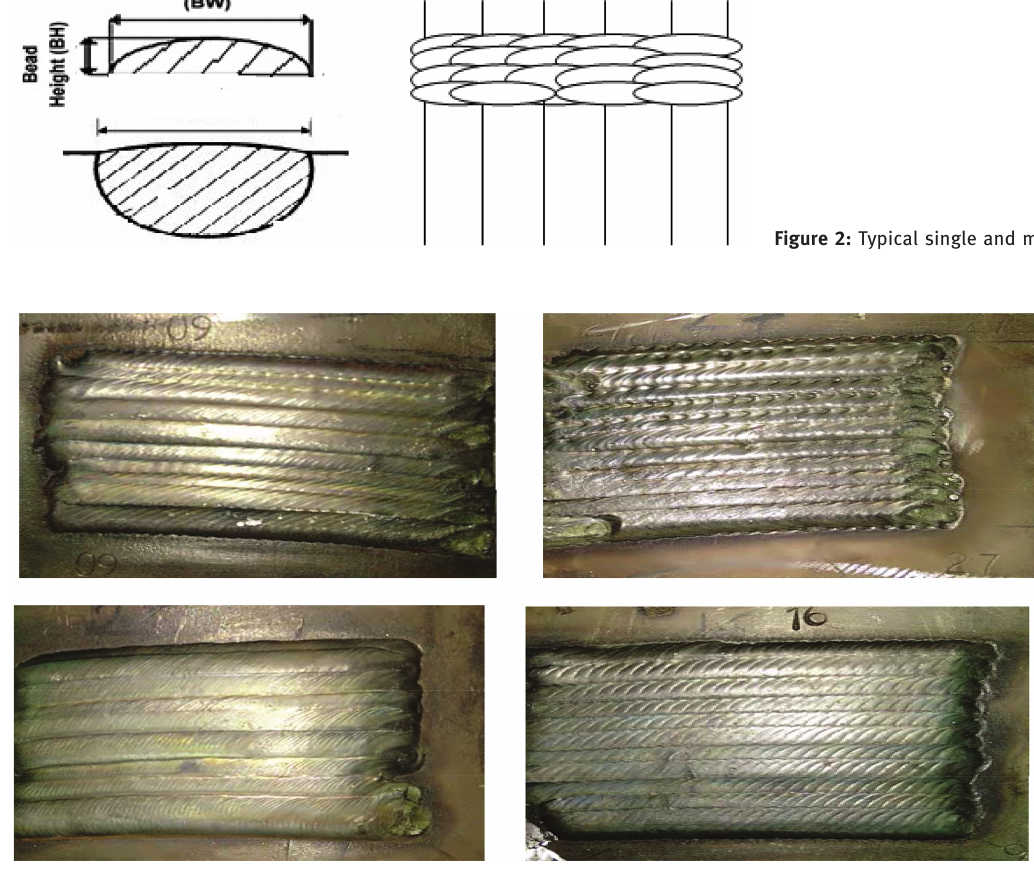
Figure 3: Few samples of multitrack deposition on the substrate plate.